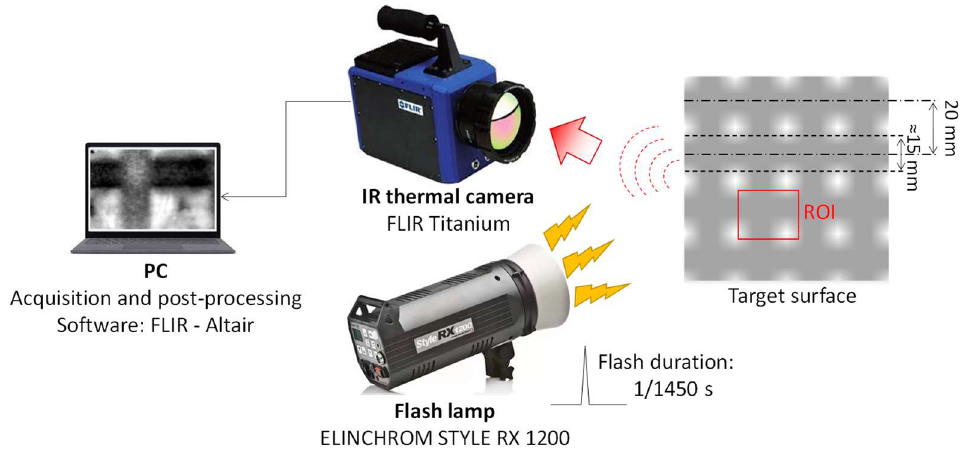
Figure 1. Schematics of the test setup. After the thermal measurements, the panel was cut with a vertical saw in correspondence with the ROI to allow observations and measurements at the SEM (Model EVO 50XVP by Zeiss, Oberkochen, Germany). The SEM was operated at a working voltage of 20 kV along with a proper working distance for a focused image using the secondary electron (SE) detection. Two samples were extracted with a band saw, as shown in Figure 2: the line in between the two samples corresponds to the axis of a horizontal hatch. S1 was used for a through-thickness analysis along the axis of the hatch (lower side), while S2 allowed for analyzing the surface and its coverage. The size of the embedded particles was measured from these SEM images in terms of equivalent diameter using the software MATLAB (version R2018a, MathWorks, Natick, MA, USA). Eventually, to support the discussion, the SEM was also used to perform a chemical analysis at the surface of the coating using energy-dispersive X-ray spectroscopy (EDS), focusing on the presence of oxygen. The SEM had a resolution of 0.1% for the measurements of elements’ concentrations; chemical measurements were repeated over 4 areas on the axis of the horizontal hatch and of the vertical hatch, far from the crossing. The concentration results were processed with the boxplot command of the software MATLAB.